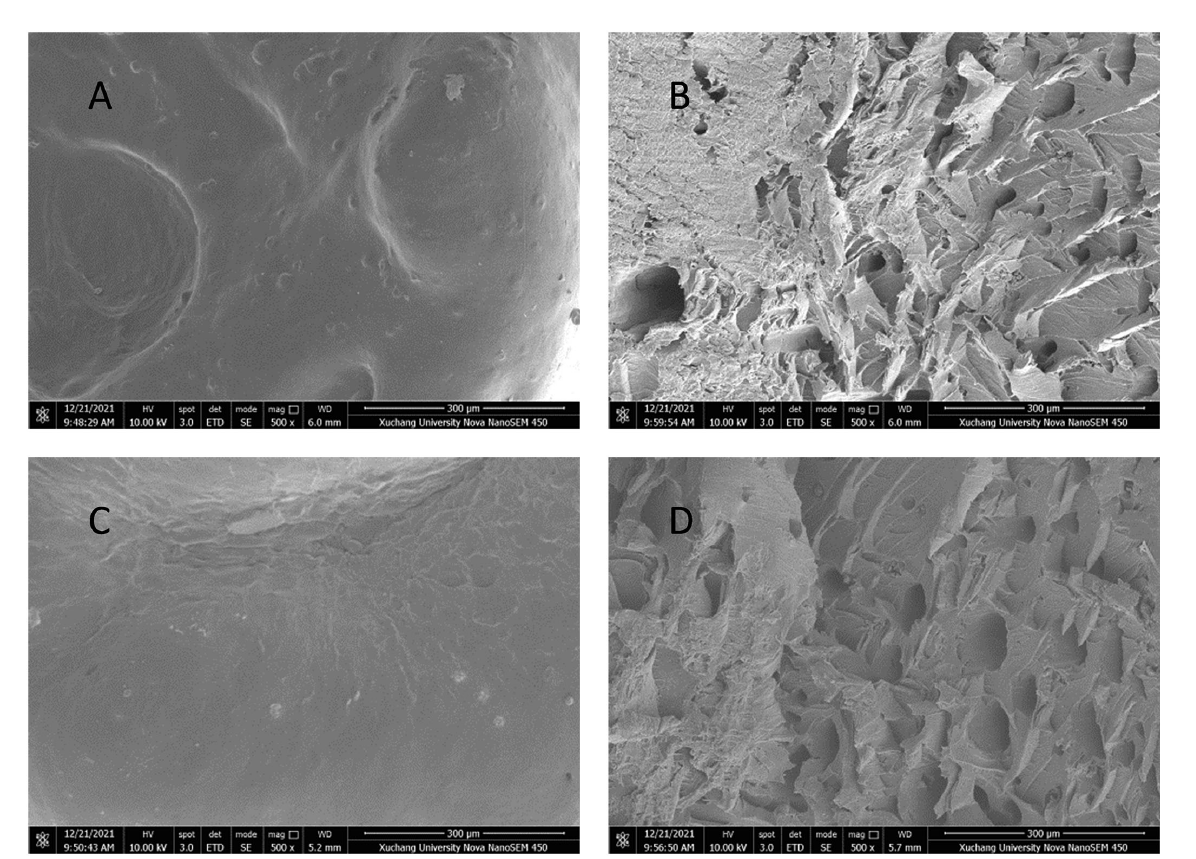
FIGURE4 Micro-images of the cross-section of starch noodles containing no antioxidant (A) , 0.20/100g of curcumin (B) , 0.15/100g of TP (C) , and lycopene (D) , respectively.